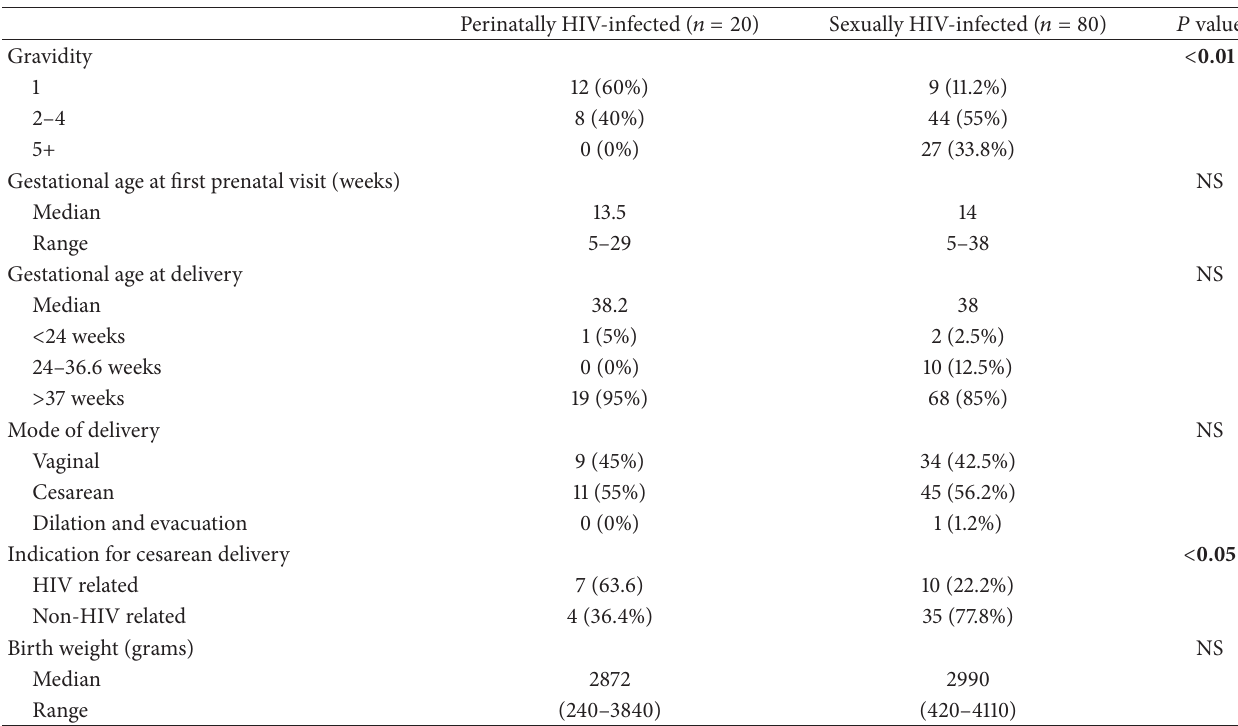
Table 2: Obstetrical characteristics of perinatally HIV-infected versus sexually HIV-infected parturients. Perinatally HIV-infected ( 𝑛 = 20 )